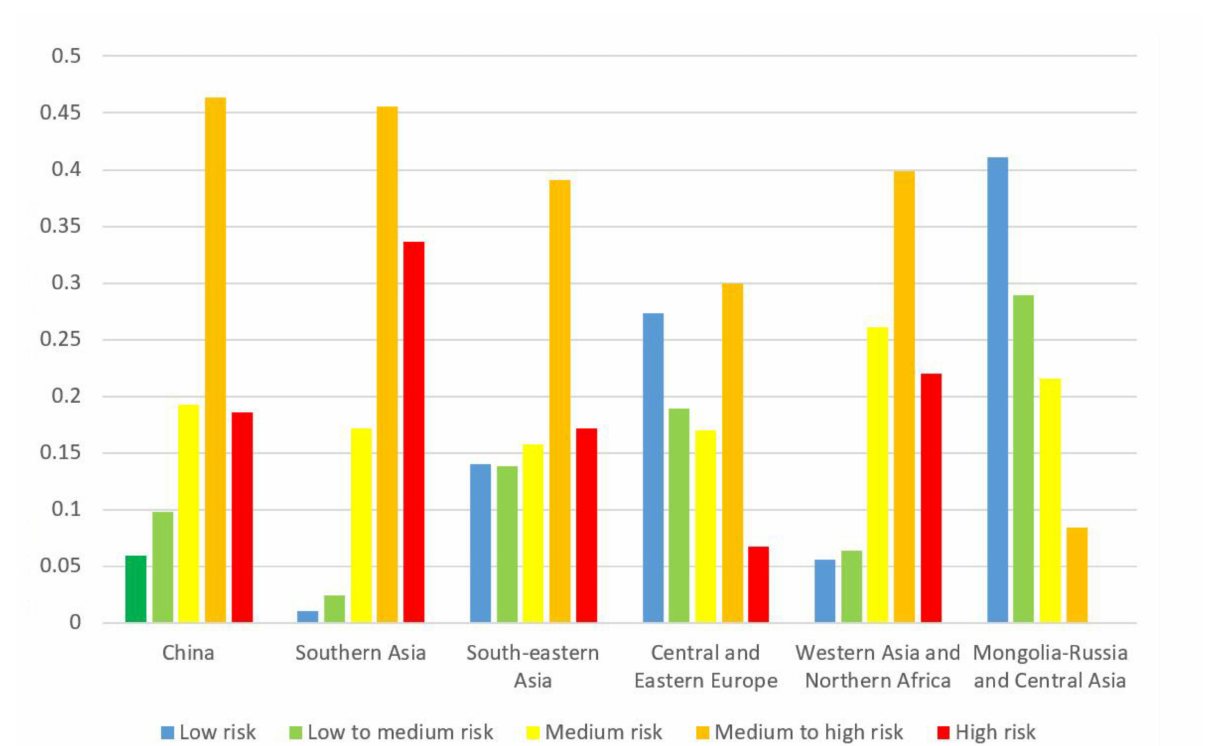
Figure 9. “Belt and Road” regional water hazard risk